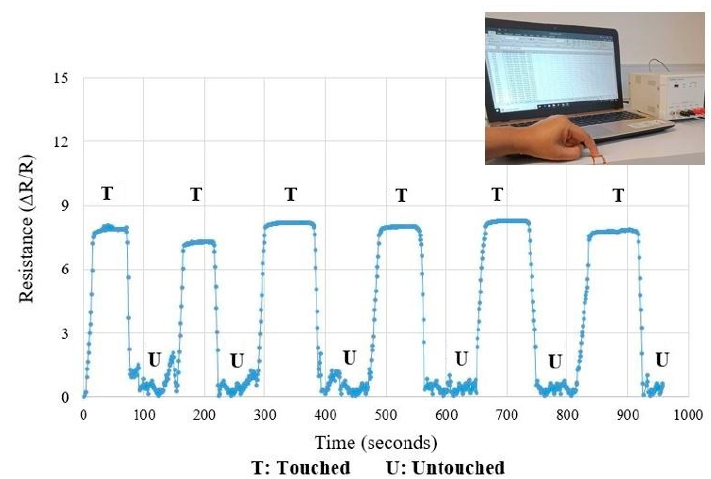
Figure 11. The response of the sensors in terms of change in relative resistance for the applied strain.